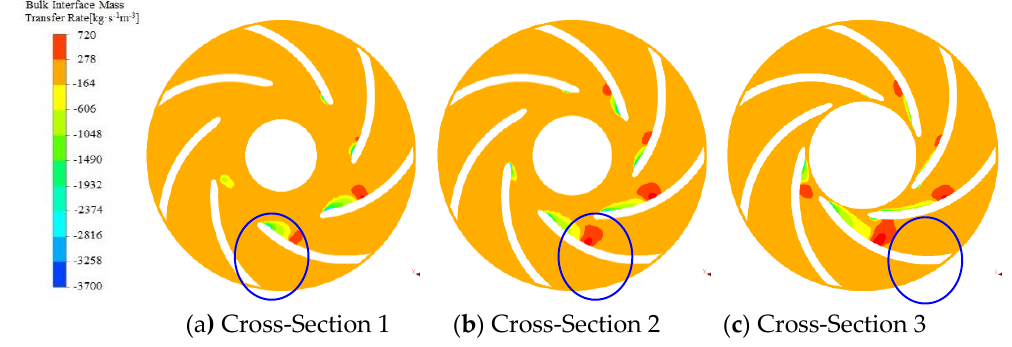
Figure 12. Bulk interface mass transfer rate with different blade cross sections.